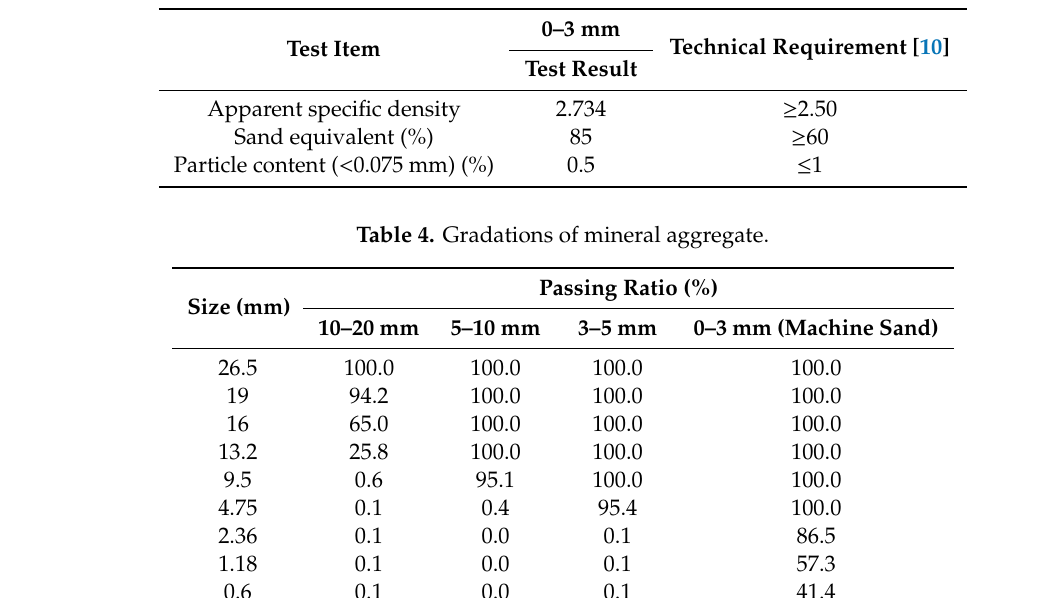
Table 3. Properties of fine mineral aggregate.